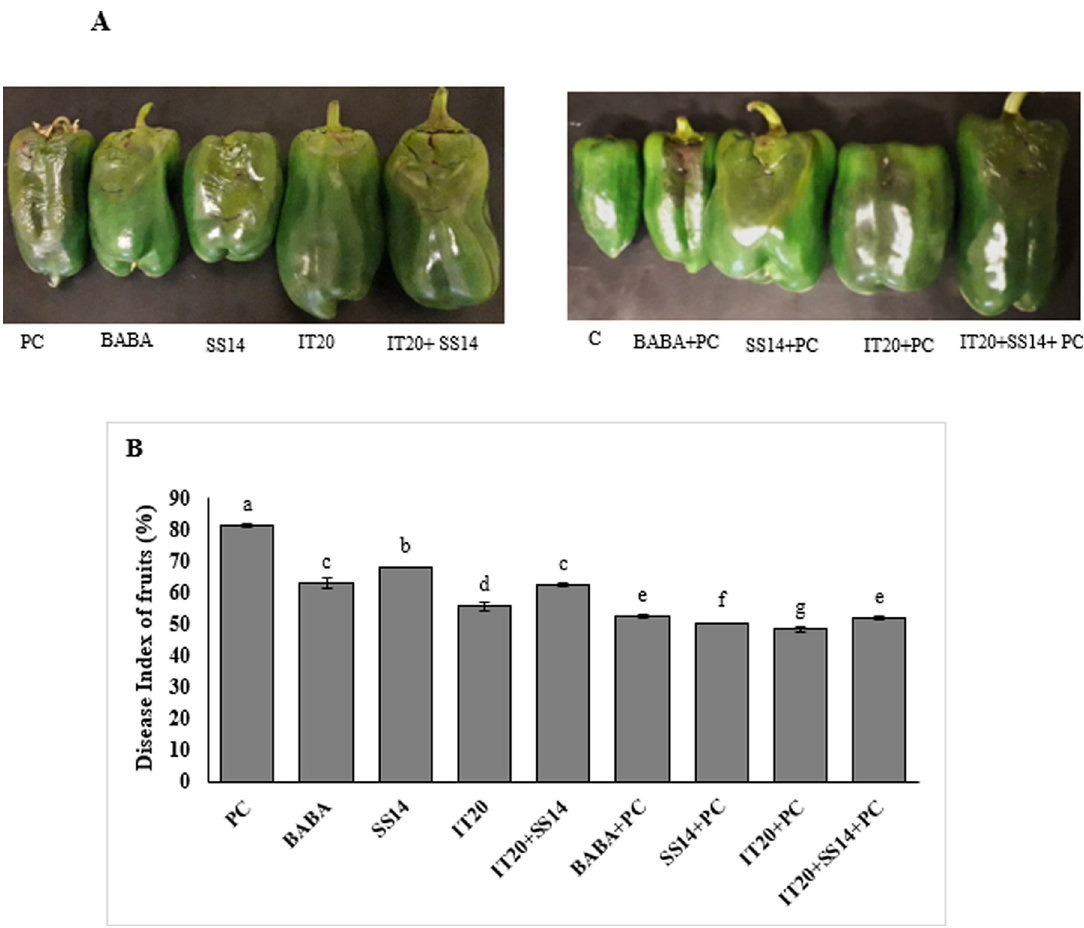
Fig 6. Disease severity ( A ) and disease index ( B ) of fruits inoculated with the zoospore suspension of Phytophthora capsici (5 � 10 6 /ml) on pre-inoculated (left) and non-inoculated (right) after five days of inoculation. The same letters represent non-significant difference according to Duncan’s Multiple Range Test ( P < 0 . 05 ). PC: inoculated control and C: non-inoculated control.